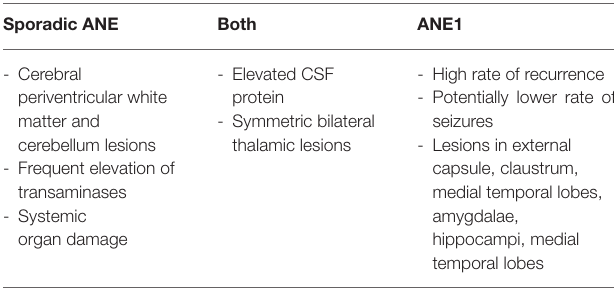
TABLE 2 | Clinical characteristics of ANE vs.